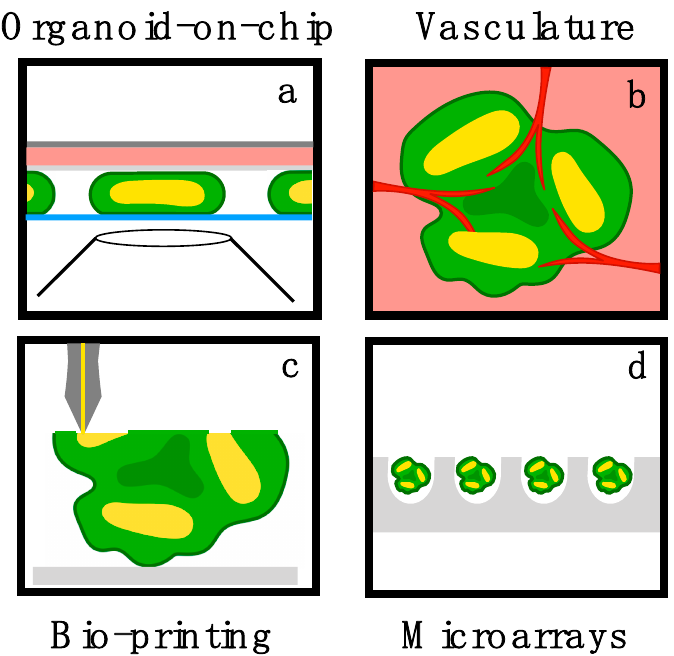
Figure 3. Bioengineering brain organoids. ( a ) On-chip approach to culture brain organoids in confined compartments for long-term live-imaging [7]. ( b ) Vasculature is essential to prevent necrosis in the organoid core, but have so far been attained only by transplanting organoids into mice brains [125]. ( c ) 3D printing and ( d ) microwell arrays are possible solutions to decrease variability between organoids cultures.